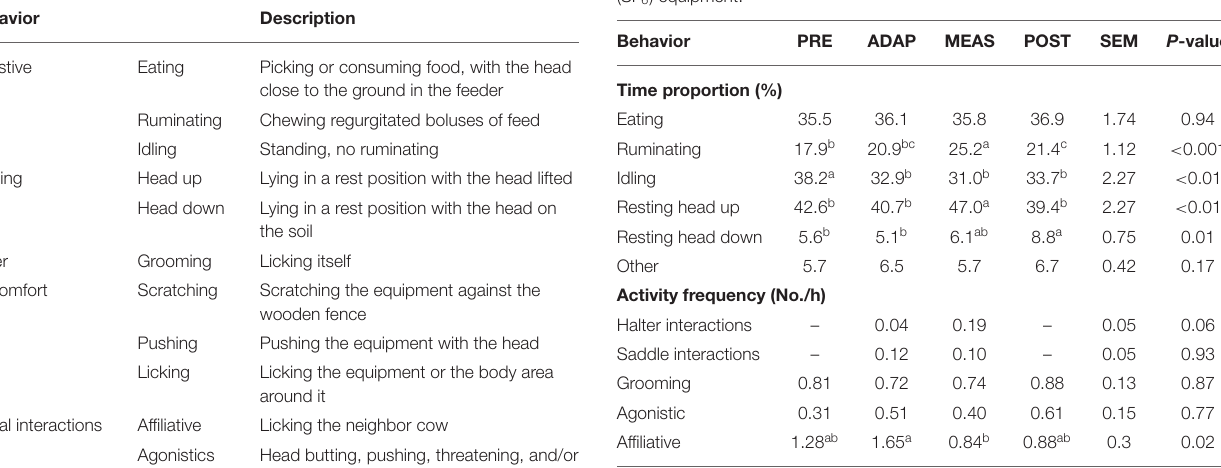
TABLE 3 | Cow behavior in each of four phases of fitting with sulfur hexafluoride (SF 6 )